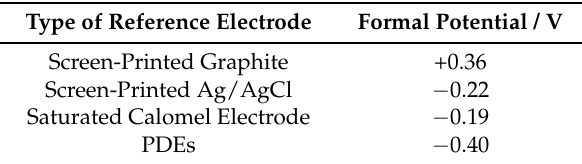
Table S3. Analysis of the formal potentials using a range of reference electrodes, using 1